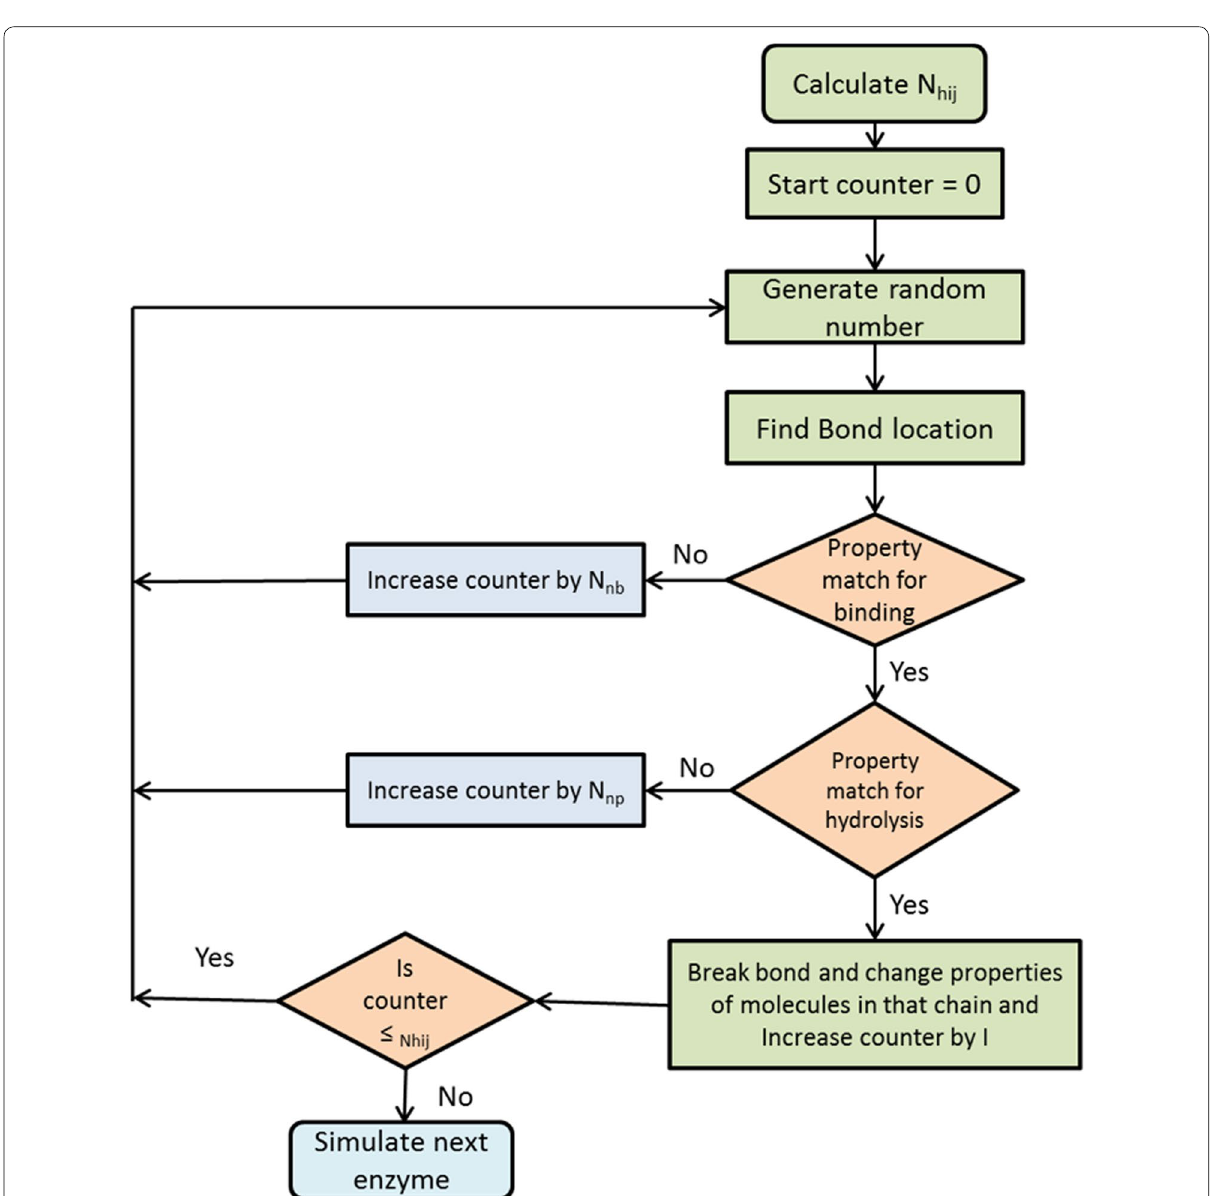
Fig. 3 Basic schematic for hydrolysis simulations in model. (Detailed schematics provided in Additional files 1 and 2.) (Adapted from Kumar